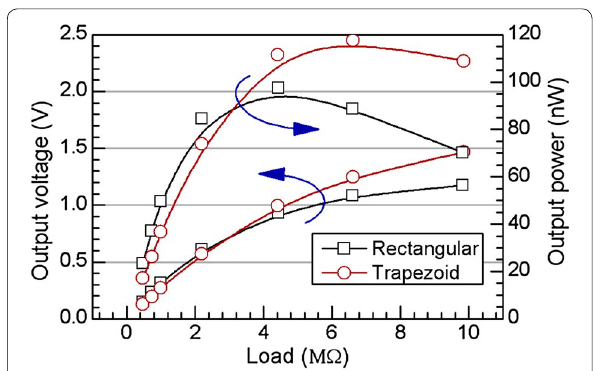
Fig. 7 Measured output voltage and power with different loads under an acceleration of 5 m/s 2 at their resonant frequencies of 97.8 and 121 Hz for the trapezoidal and rectangular shaped cantilever devices,